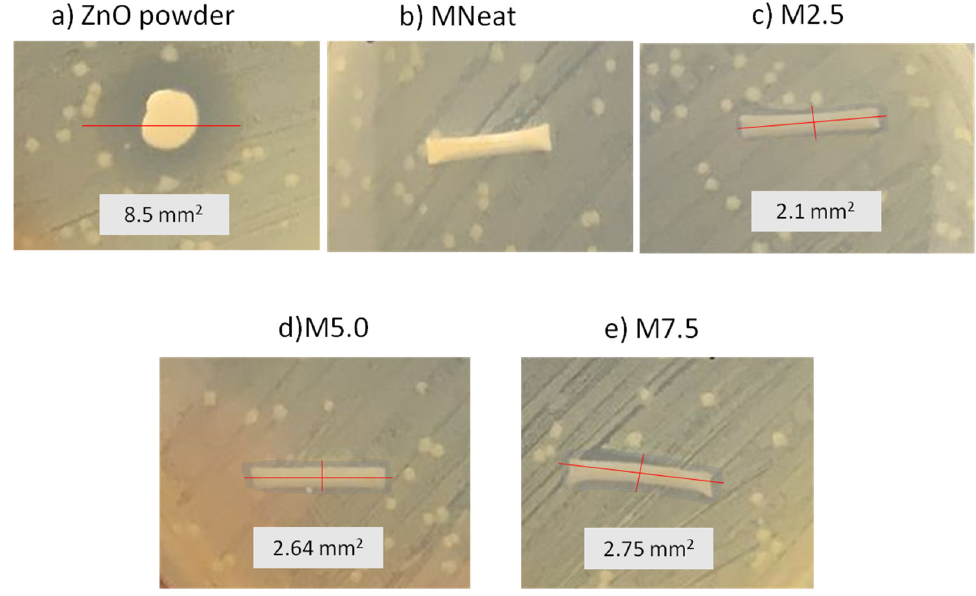
Figure 6. Bacterial growth inhibition of ( a ) ZnO powder ( b ) neat MNeat ( c ) M2.5 ( d ) M5.0 and ( e ) M7.5 AHFM. ( e ) M7.5